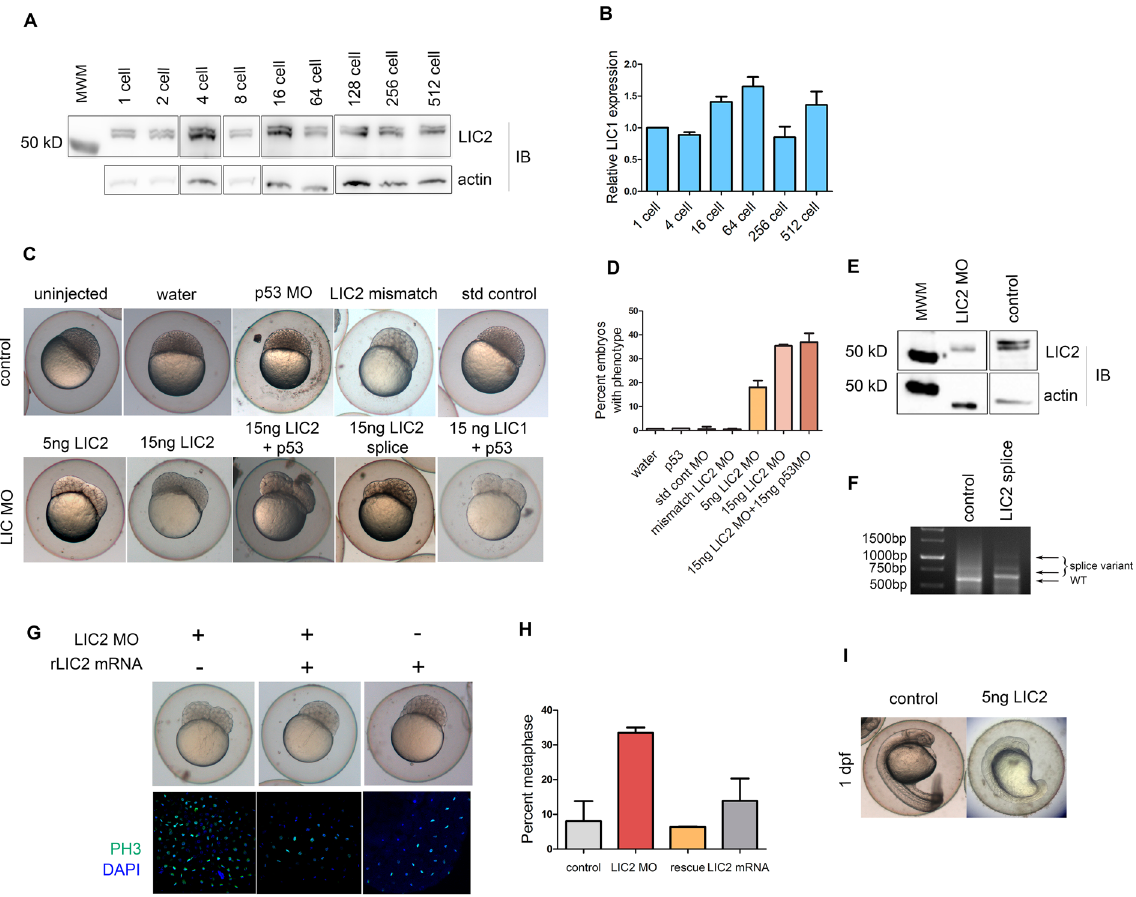
Figure 6. Zebrafish LIC2 is required for early embryonic development. ( A ) zLIC2 expression at early stages of zebrafish embryogenesis, as shown by immunoblotting of whole embryo lysates. ( B ) zLIC1 expression at early stages of zebrafish embryogenesis, as shown by real time PCR analysis. ( C ) Knockdown of zLIC2 in zebrafish embryos. Top–control embryos as indicated. Below–depletion of zLIC2 by zLIC2-specific morpholinos as indicated. ( D ) Fraction of embryos showing the furrow phenotype. ( E ) Western blot showing zLIC2 knockdown using translation blocker LIC2 MO (the top zLIC2 band completely disappears upon MO treatment). β -actin serves as loading control. ( F ) Reverse transcriptase PCR showing splice variants in LIC2 splice morpholino injected embryos (arrows). Lane 1 = molecular weight ladder. ( G ) Gross embryo morphology (top) and phosphohistone 3 staining (bottom) of embryos injected with LIC2 morpholino and/or rLIC2 mRNA as indicated. ( H ) Fraction of cells in metaphase from morphants, rescued and mRNA injected embryos from G. N = 17, 28 and 20 embryos respectively from 2 experiments. ( I ) Representative embryo injected with 5 ng translation blocker MO against zLIC2 show developmental delays at 1